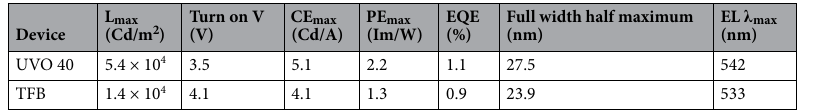
Table 2. Device performance of the QLEDs on the PEN substrates with TFB and PTAA HTLs.